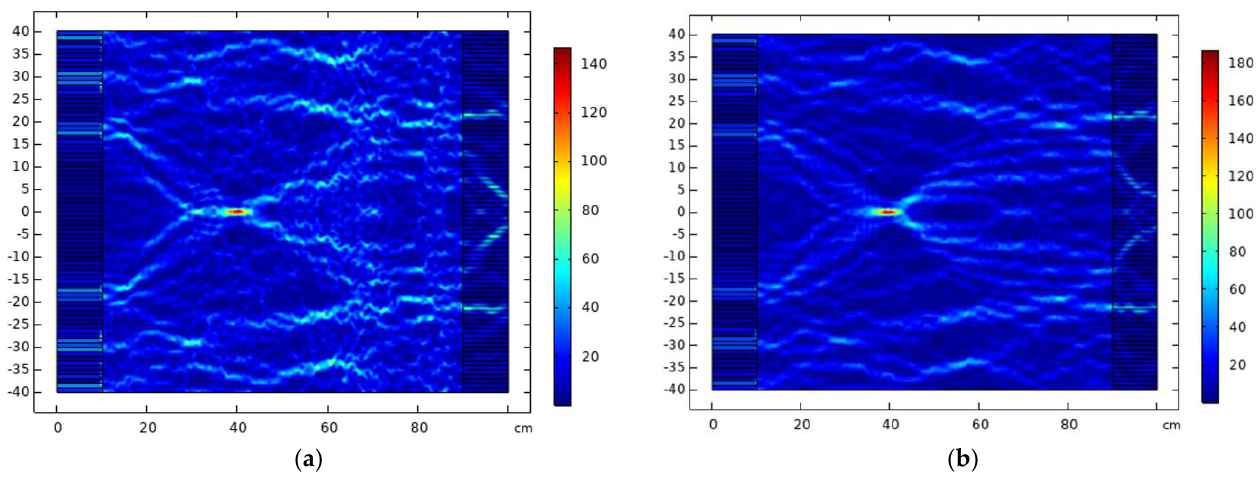
Figure 20. Spatial distributions of acoustic intensity field through focusing lens at ( a ) 28 kHz and ( b ) 35 kHz.